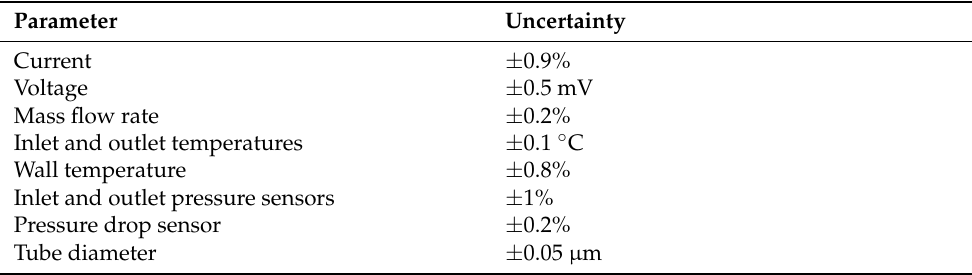
Table 3. Uncertainty parameters in the